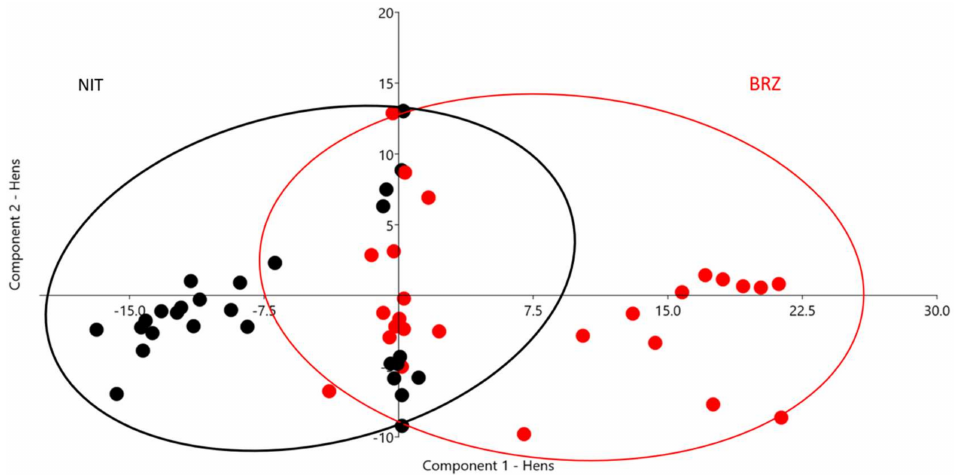
Figure 2. Scatter plot principal component analysis (PCA) for morphometric parameters and in- dexes in hens. Every spot represents a bird, and every color a breed (BRZ = red: Brianzolo breed, NIT = black: Nero d’Italia breed; ellipses are a visual grouping sign). PC1 determines 52.60% of the variance in females, and the two determining variables are SHL (0.94) and SHB (0.20). PC2 determines 17.14% and is influenced by SD